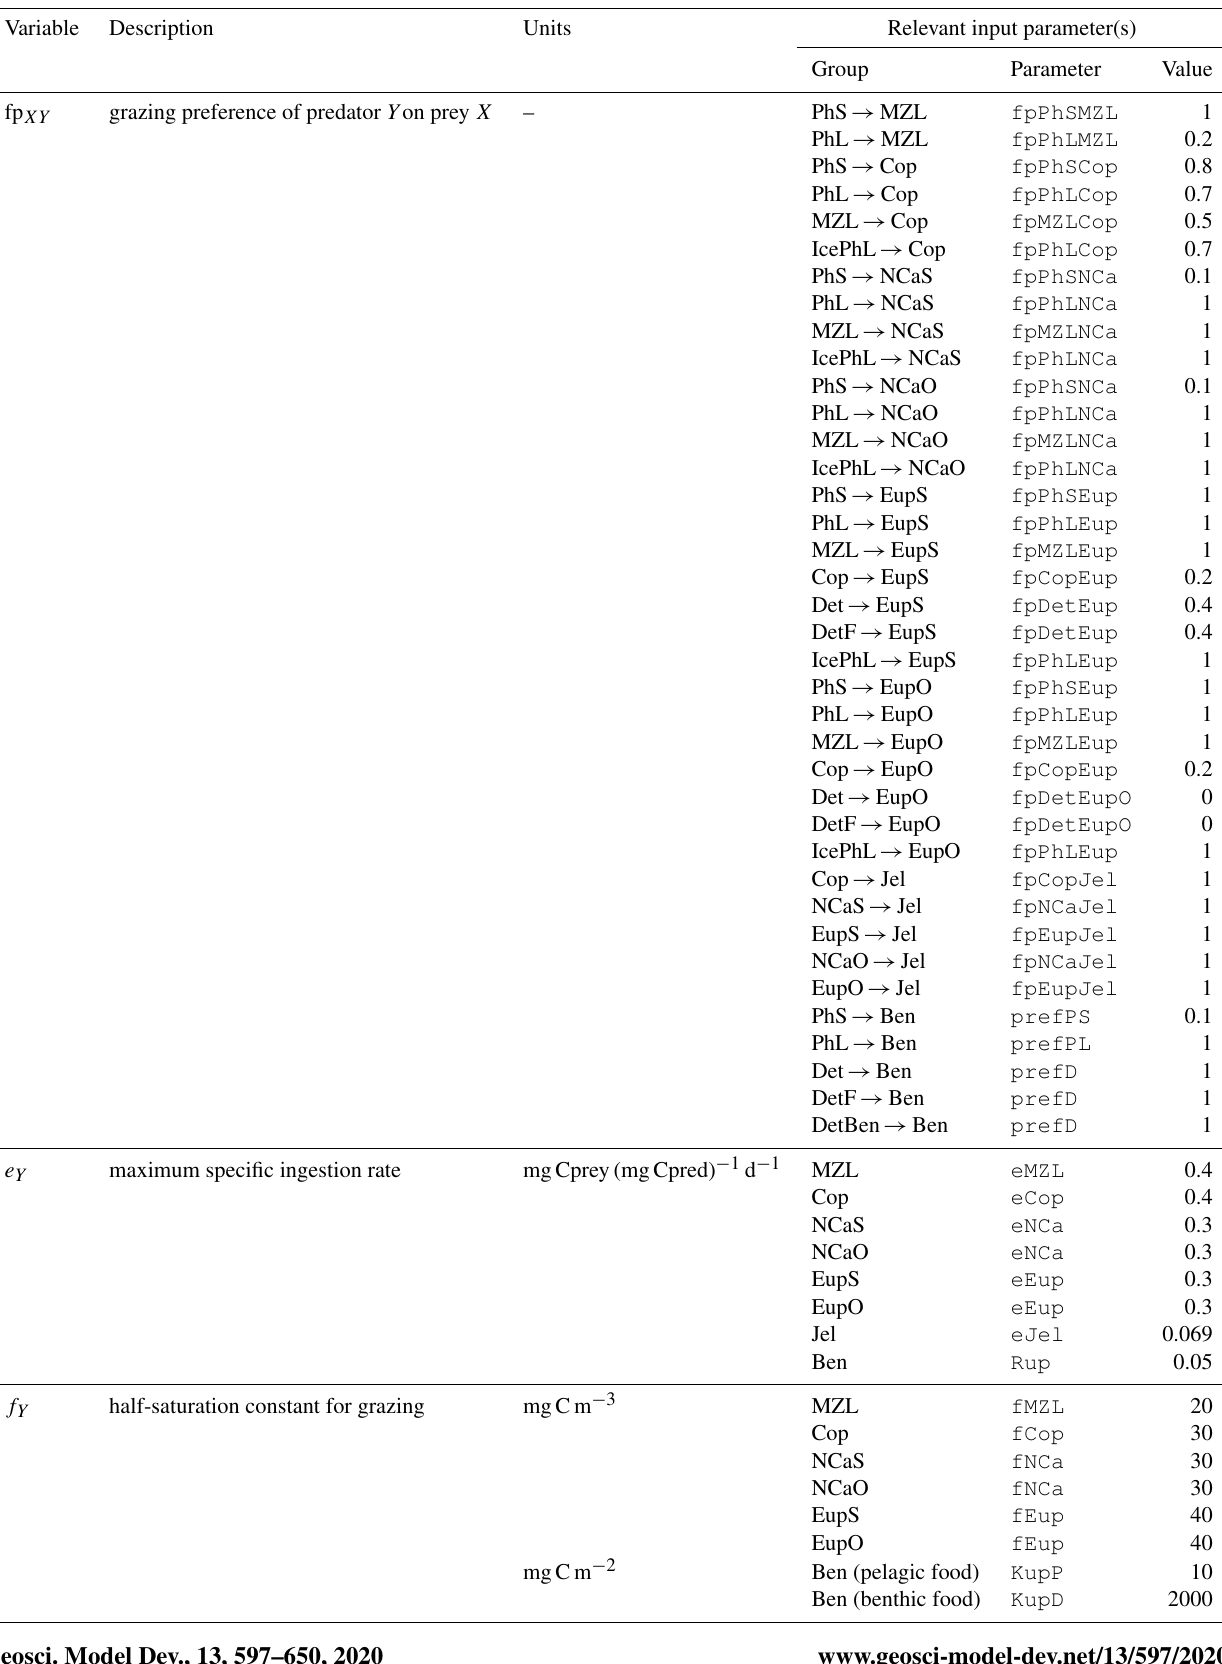
Table A6. Notation and description for input parameters related to grazing and predation.